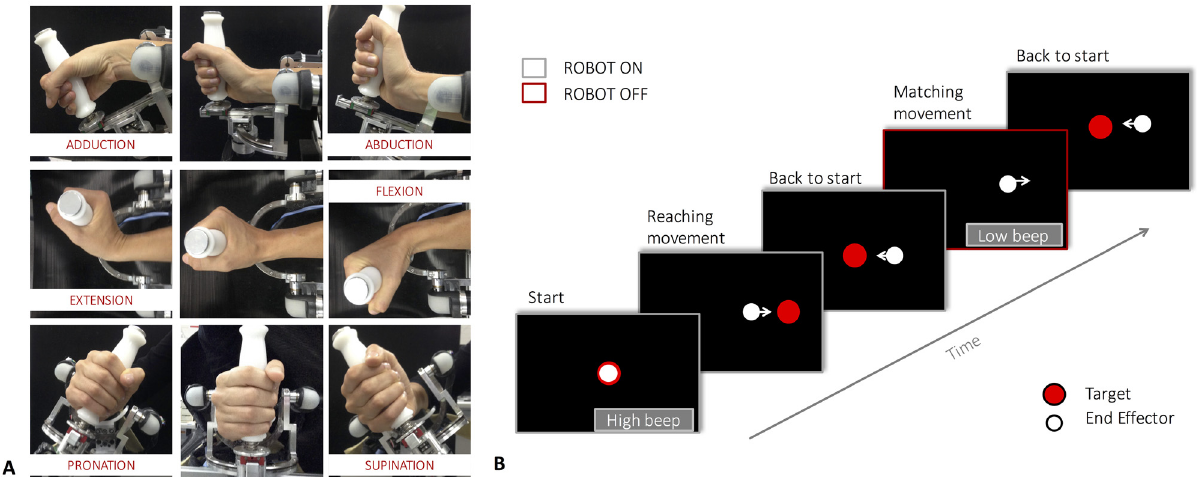
Fig 1. A) Wrist ’ s DoFs and movements involved in the task (flexion/extension, abduction/adduction and pronation/supination), with reference to an initial neutral position. Wrist motion is measured/actuated by the robotic exoskeleton shown in the figure. B) The temporal sequence of the experimental paradigm. An auditory cue marks the beginning of the trial and the wrist is passively moved by the robotic device from the neutral configuration to the proprioceptive target. After a consistent holding time of 3 seconds, the joint is passively returned to the initial starting position. Another auditory cue indicates participants to start moving and actively reproduce, the joint configuration previously experienced. In this phase the robot is inactive. When the end effector speed is below a 2°/second for more than 2 seconds, the robot moves the wrist back to the neutral position and another trial can